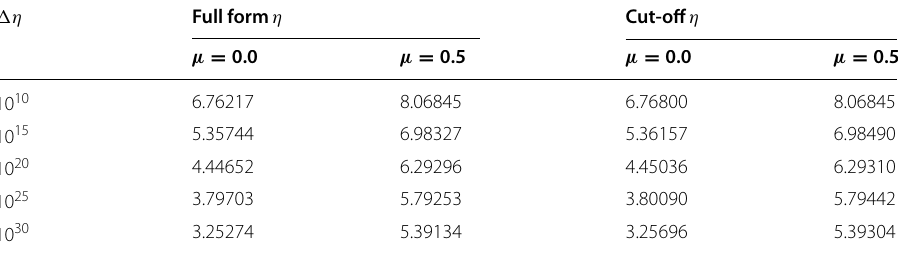
Table 3 Comparison of Nusselt number, Nu of full-form viscosity function (11) and cut-off viscosity function (13) for µ = 0.0 and µ = 0.5 at Ra = 10 7 and θ 0